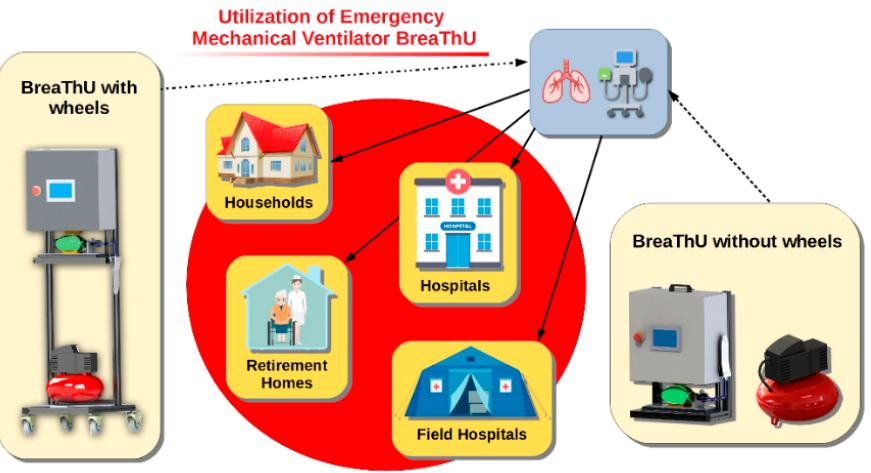
Figure 1. Utilization of the emergency mechanical ventilator BreaThU.